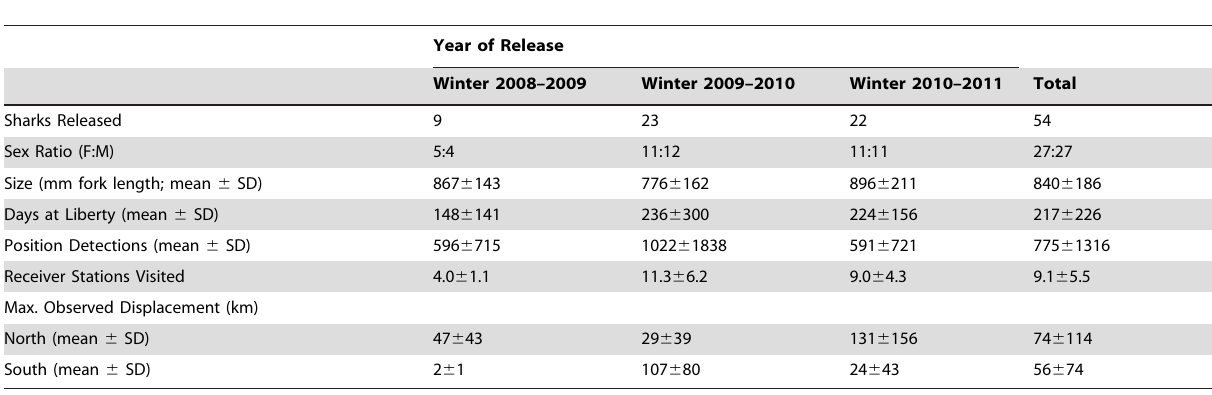
Table 1. Summary information for all 54 lemon sharks tagged at Cape